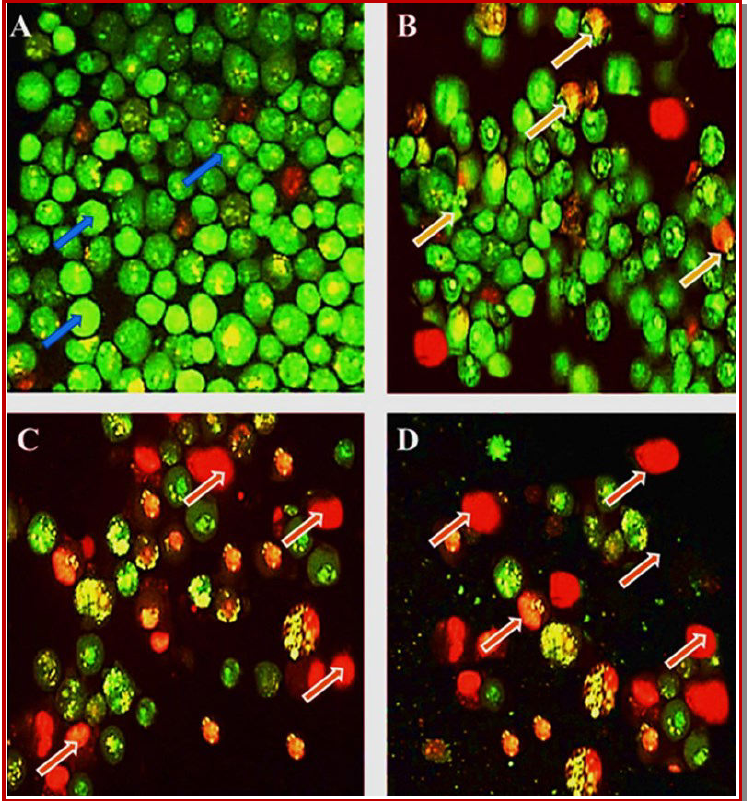
Figure 4: Fluorescence microscopy evaluation of the syringin-induced apoptosis in HeLa human cervical cancer cells. The cells were treated with 0 (A), 10 (B), 50 (C) and 100 µM (D) of syringin for 48 hours, stained with AO/PI double staining and then ana- lyzed using fluorescence microscopy (magnification 400x). Blue arrows indicate viable cells, yellow arrows indicate cells with early signs of apoptosis like chromatin condensation and membrane blebbing, while as red arrows indicate late apoptotic cells